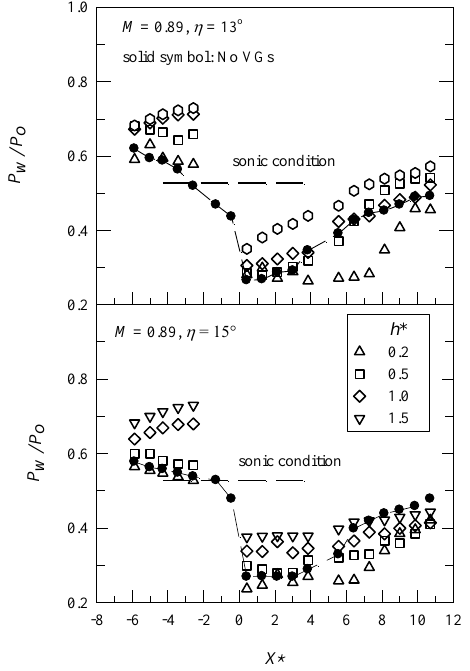
Figure 5. Mean surface pressure distributions for M = 0.89. The variation in ( P w /P 0 ) min and M peak with β is shown in Figure 6. For the baseline case, which is shown as solid symbol, there is an increase in the value of M peak or a decrease in ( P w /P 0 ) min as β increases. This depends on M if VG1 ( h* = 0.2) is installed. For M = 0.83 ( β = 16.1 and 22.6), the values of ( P w /P 0 ) min and M peak are approximately the same as those for the baseline case. This is not true for M = 0.89 ( β = 18.5 and 26.1), for which there is a decrease in ( P w /P 0 ) min and an increase in M peak . As mentioned previously, this is due to stronger convection. For h* = 0.5, the presence of VG2 has a minor effect on flow